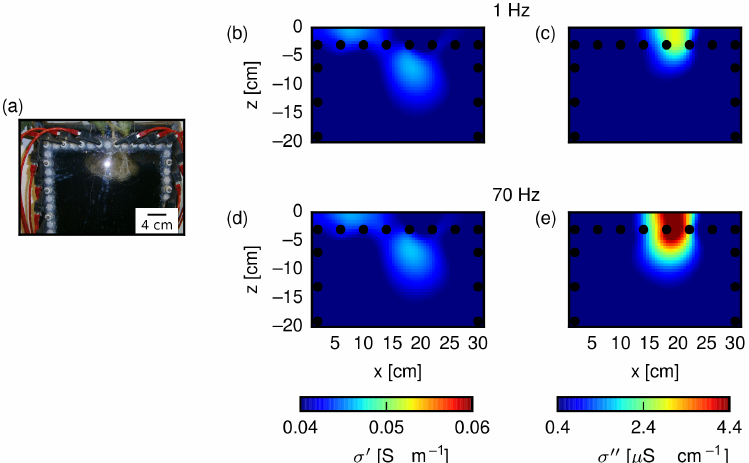
Figure 6. Single-frequency inversion results in terms of real (b, d) and imaginary (c, e) components of complex conductivity for 1Hz (b, c) and 70Hz (c, e) at the first time step. The photograph of the root system at this time (a) shows the same area of the rhizotron as the inversion